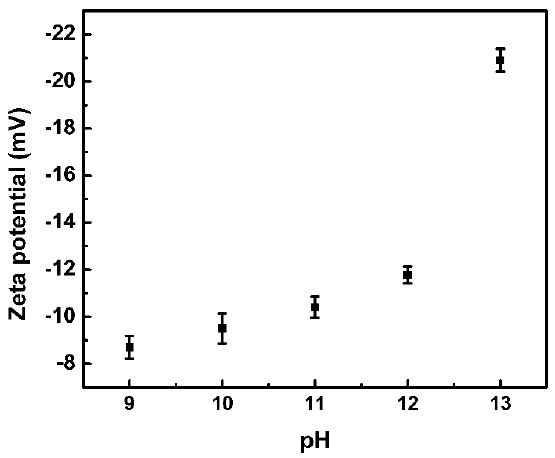
Figure 3. Zeta potential of PS- b -PAA micelle in water under various pH conditions with error bars.